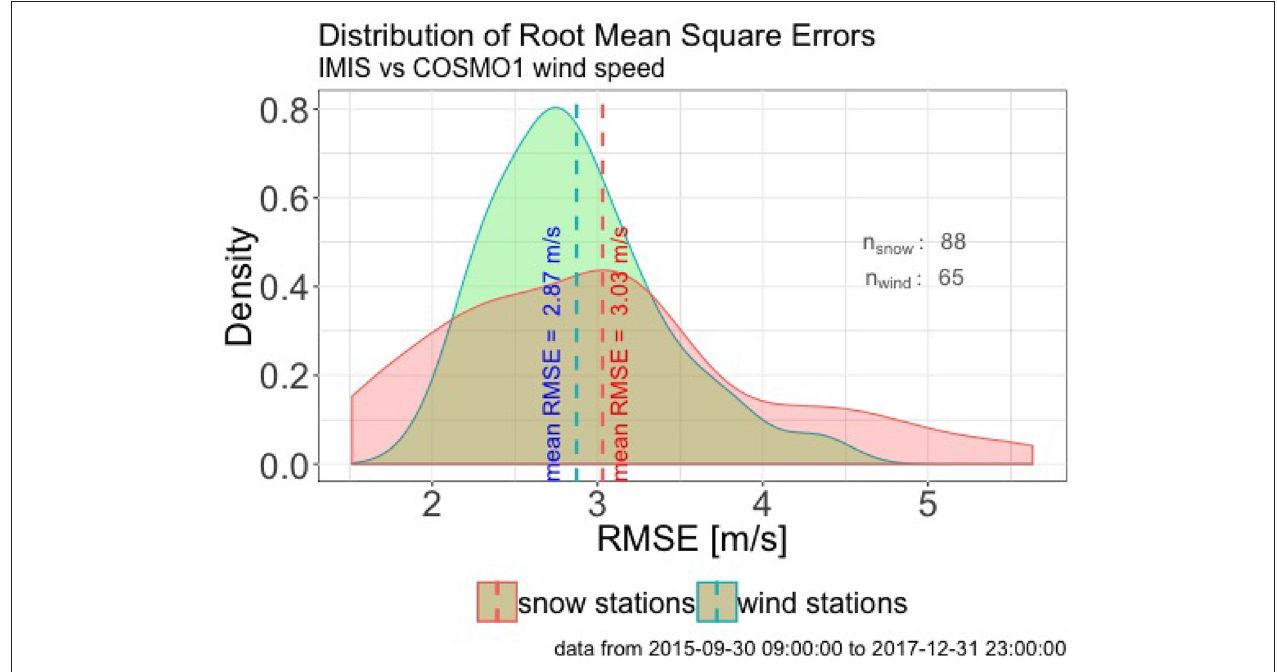
FIGURE 3 | Root Mean Square Error (RMSE) between IMIS and COSMO-1 wind speeds. The plot shows the distribution of the individual RMSE’s, that were calculated as the RMSE between each station’s observed (measured) time series and the time series of the corresponding COSMO-1 grid